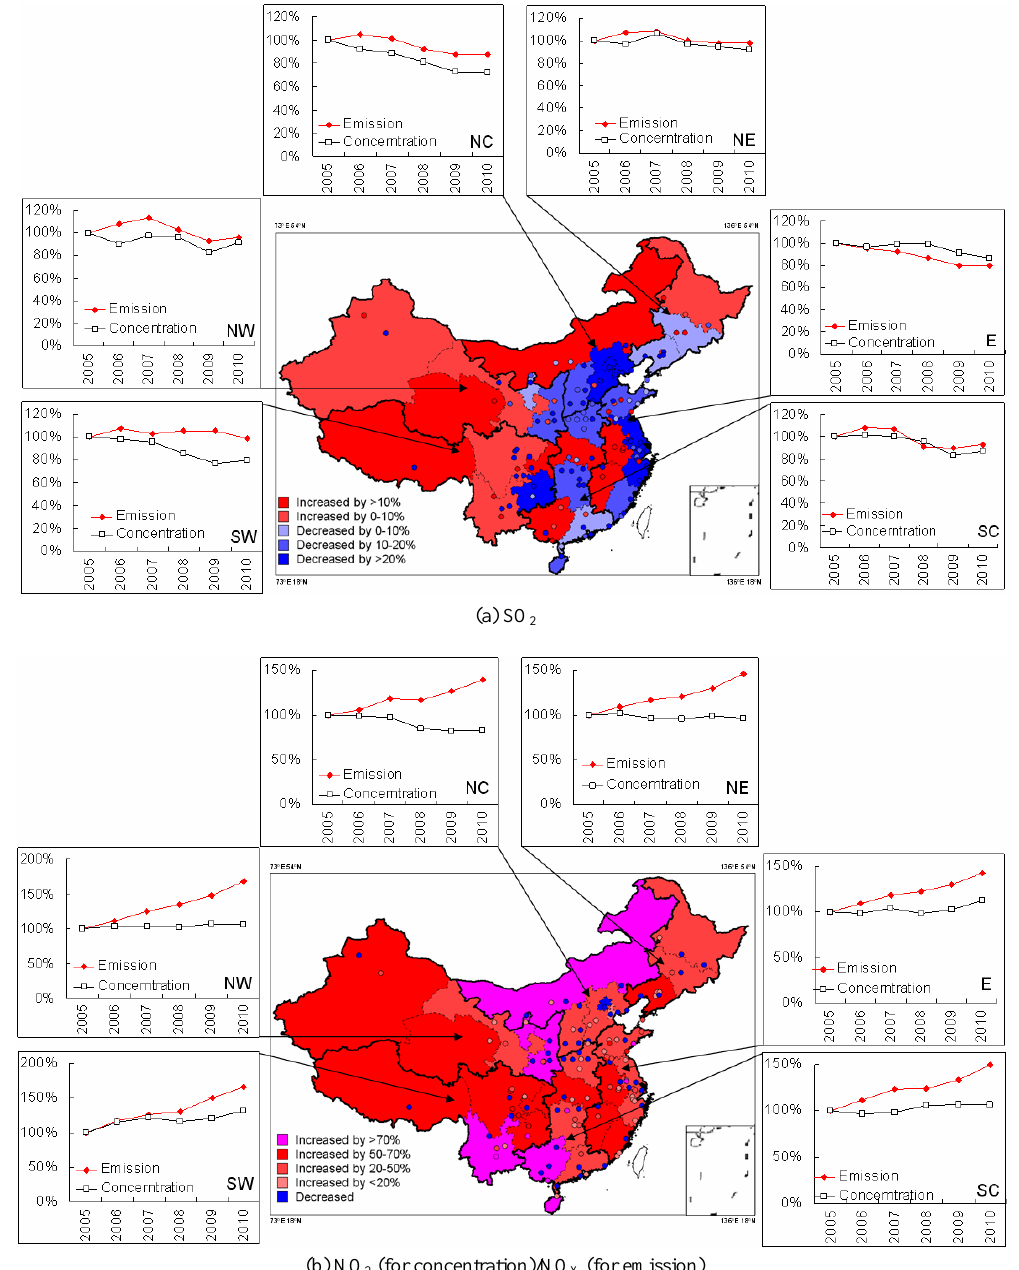
Fig. 4. Inter-annual trends of the average ambient concentrations for 113 key cities reported by MEP and emissions estimated by this work. The maps illustrate the changes in emissions by province and concentrations by city between 2005 and 2010. The panels around the maps illustrate the relative changes in emissions by region and concentrations by city from 2005 to 2010. Thick lines in the maps indicate borders of the six regions: North-central China (NC), Northeast China (NE), East China (E), South-central China (SC), Southwest China (SW), and Northwest China